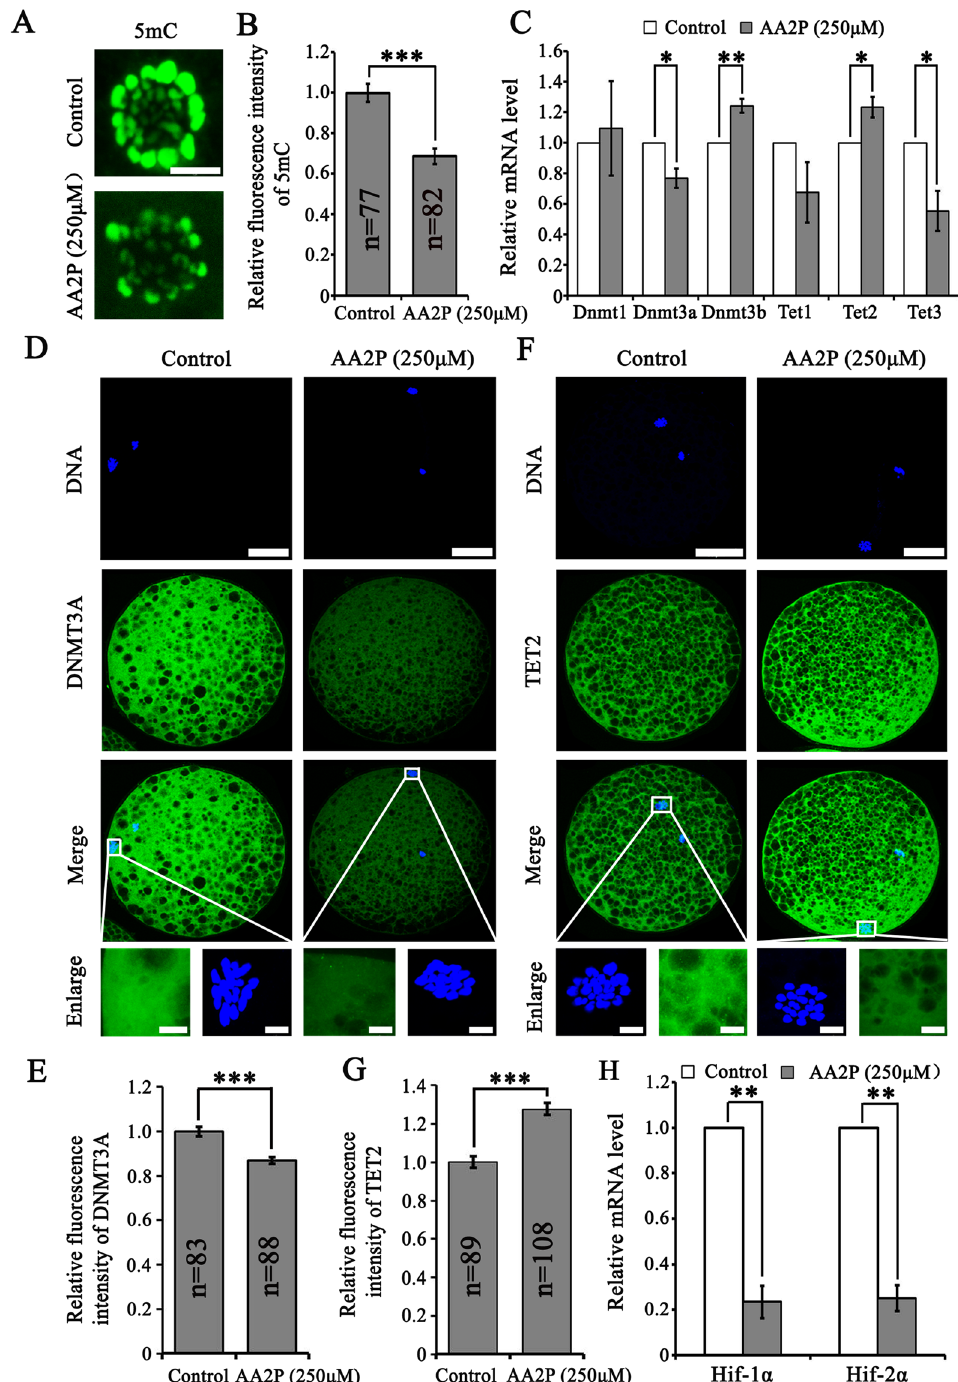
Figure 4. AA2P decreases 5 mC levels in pig oocytes. ( A ) Immunofluorescence staining of 5 mC in mature oocytes from control and 250 µ M AA2P treated groups. ( B ) Quantitative analysis of 5 mC levels in mature oocytes from control and 250 µ M AA2P treated groups. ( C ) Relative mRNA levels of 5 mC-related writers ( Dnmt1 , Dnmt3a , Dnmt3b ) and erasers ( Tet1 , Tet2 and Tet3 ) as detected by RT-qPCR. ( D , E ) Immunofluorescence staining and signal values of DNMT3A. ( F , G ) Immunofluorescence staining and signal values for TET2. ( H ) RT-qPCR analysis of Hif-1 α and Hif-2 α . Scale bar: 50 µ m for first three rows in D and F, 5 µ m in A and for final rows in D and F. * Indicates significant difference at P < 0.05 level, ** P < 0.01 level and *** P < 0.001